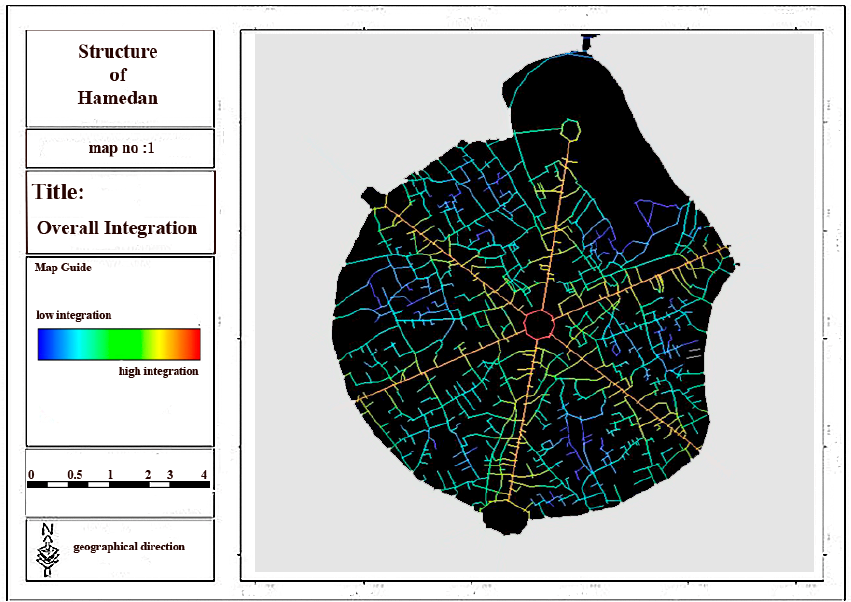
Figure 4. Overall integration of the main structure of city.